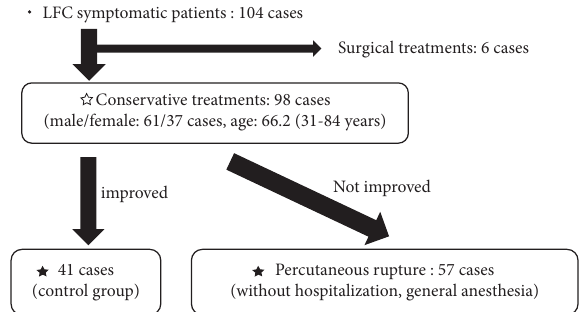
Figure 1: Flowchart of the treatment process for LFC. LFC, lumbar facet